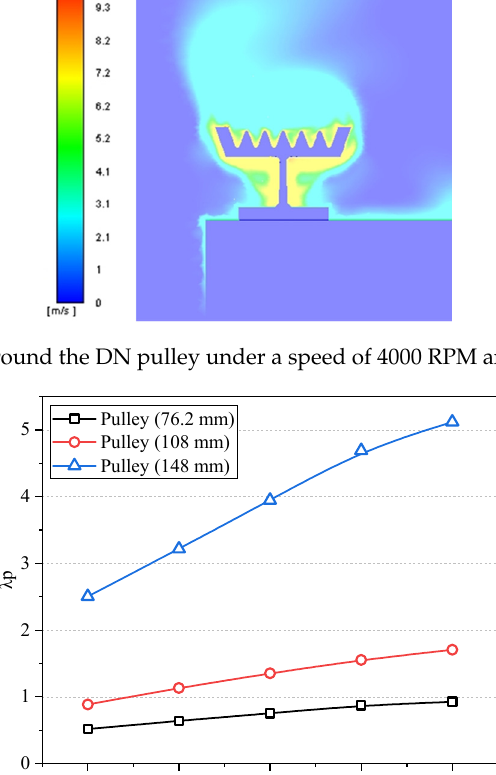
Figure 15. Curves of S n ( ω pn ) for three pulleys under various rotation speeds.